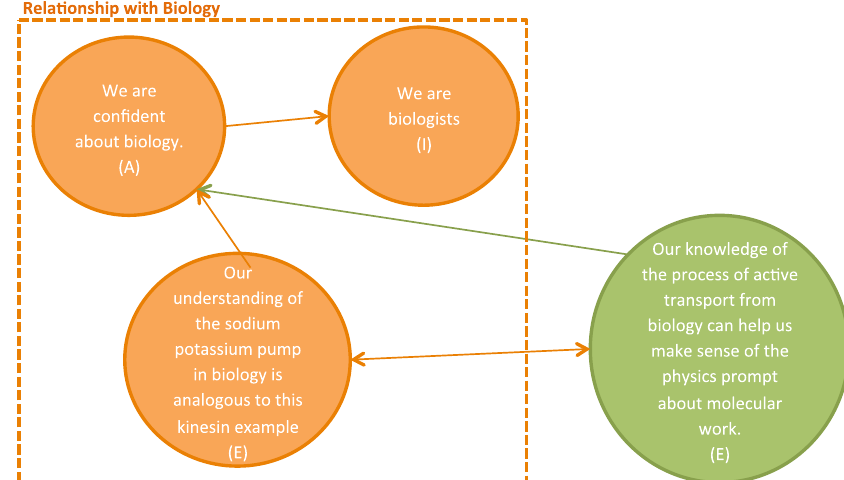
FIG. 8. A representation of the cascading of events that occurs in clip 11 as it fits into understanding Violet ’ s relationship with biology and the developing epistemological stance of biology being relevant to solving problems in